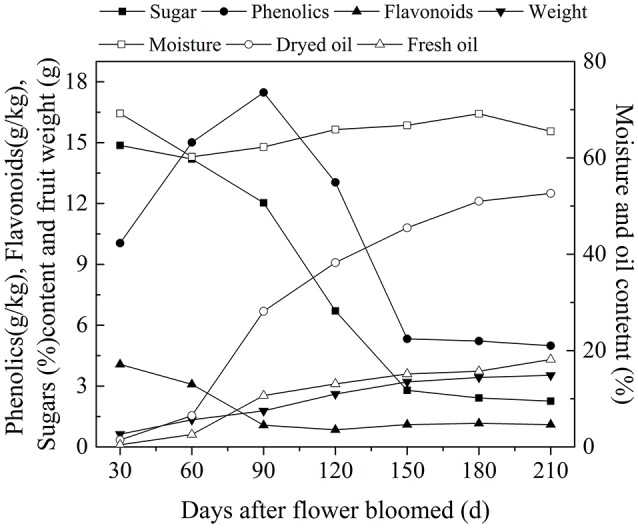
The variation of biochemicals content in olive fruit of southwest China. The data are the average value of the 10 varieties.